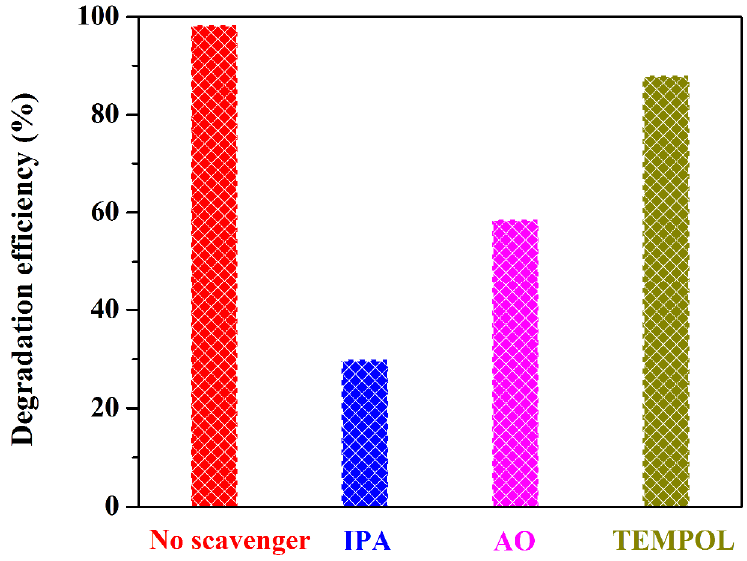
Figure 9. Active species quenching experiments.4-hydroxy-2, 2, 6, 6-tetramethylpiperidine-N-oxyl (TEMPOL), isopropanol (IPA), and ammonium oxalate (AO).